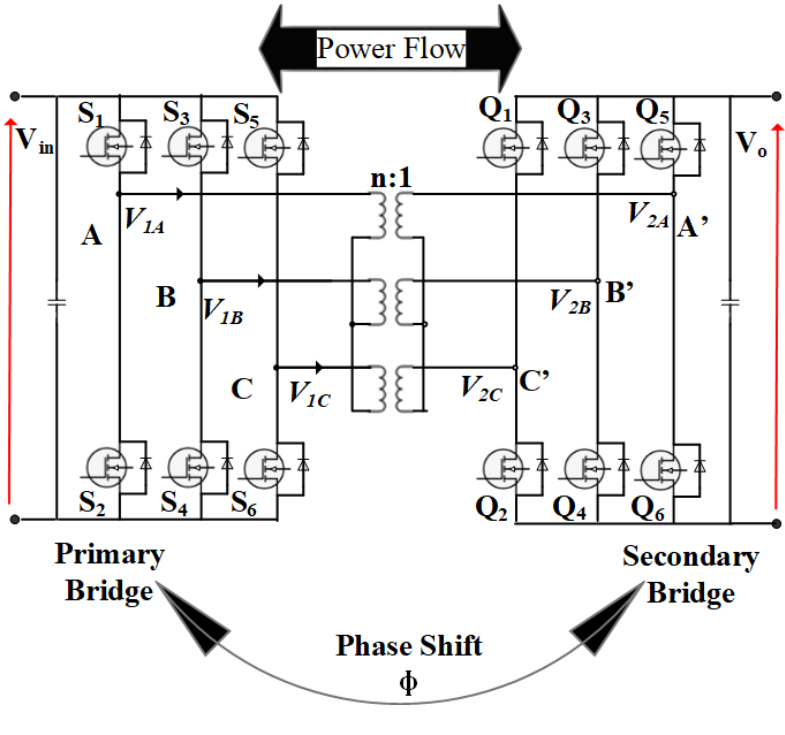
Figure 3. Conventional 3P-DAB